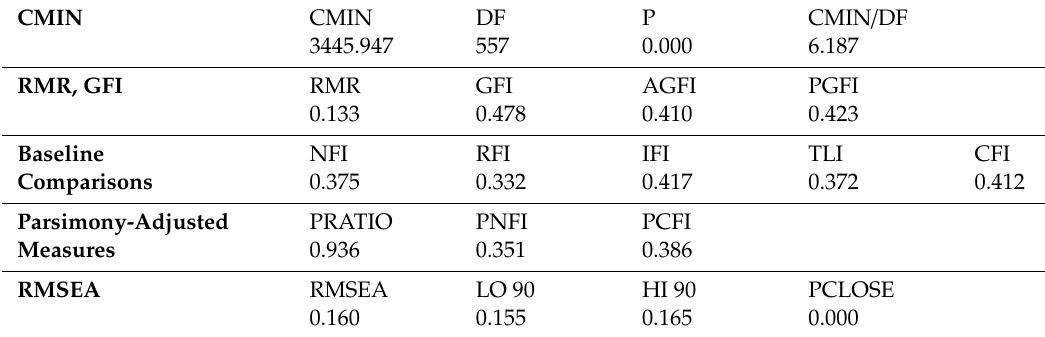
Table 2. Conceptual measurement model